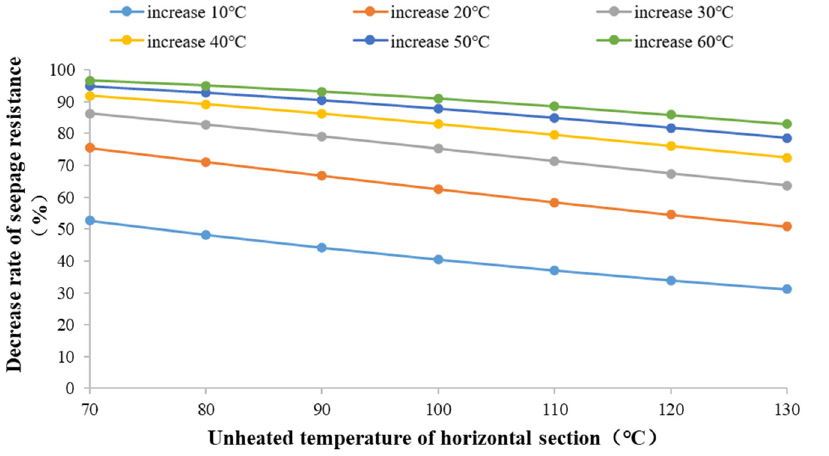
Figure 9. Wellbore porous flow resistance reduction ratio under different electrically enhanced temperatures.